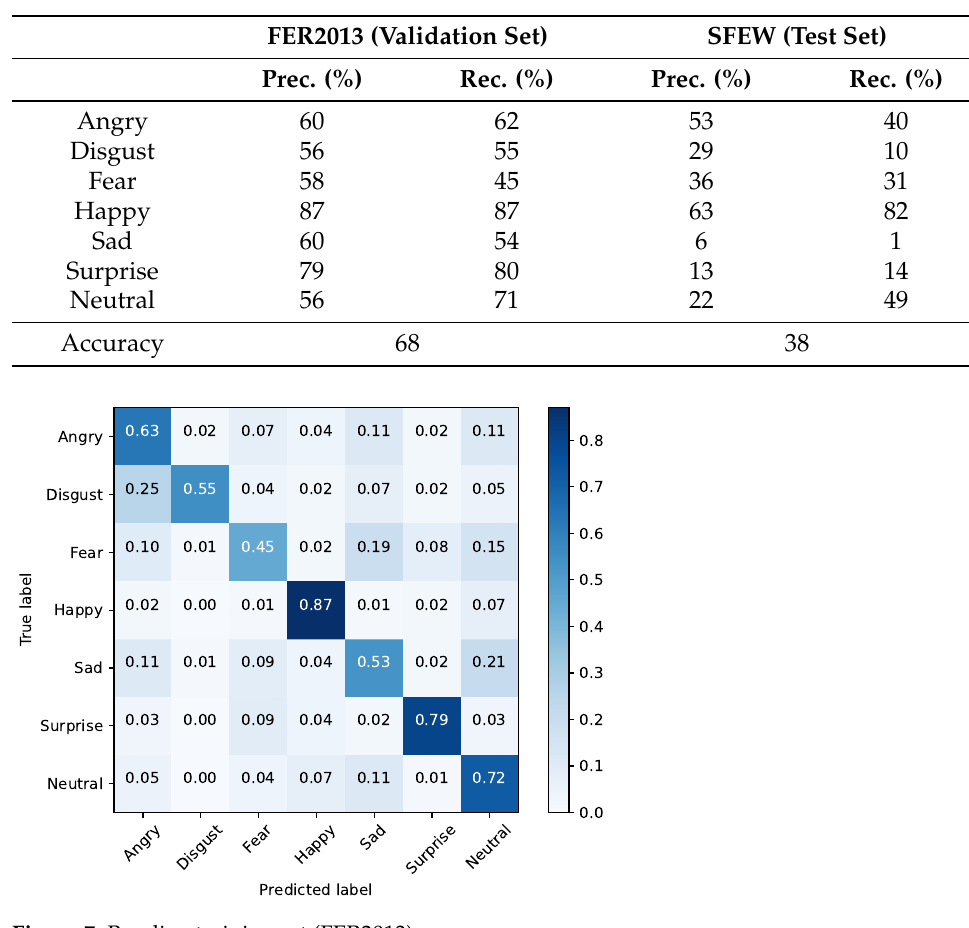
Figure 7. Baseline training set